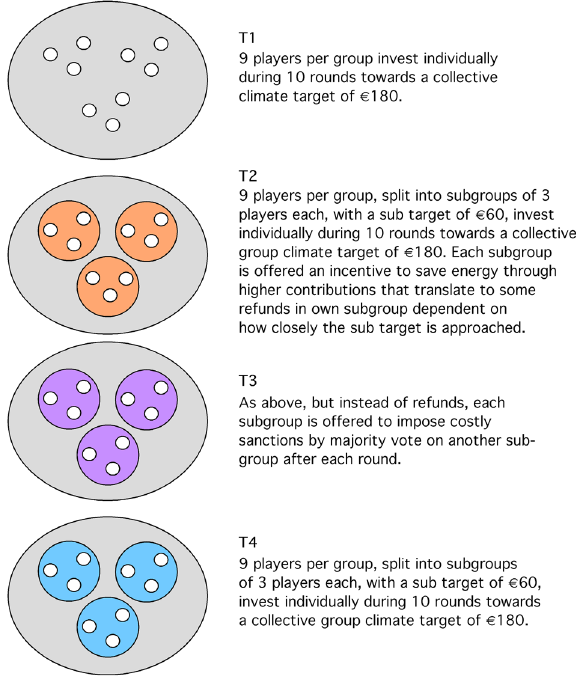
(Fig. 1). We use groups of 9 volunteers, to be divided in sub- groups of equal size. The participants interacted in a variant of the ‘ collective-risk social dilemma ’ game (Milinski et al., 2008). each of ten rounds, to contribute € 0, € 2 or € 4 from this endowment into a ‘ climate account ’ . After ten rounds, the game